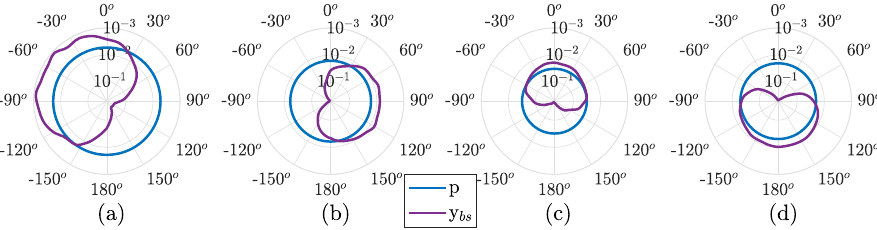
Figure 11. Polar BER for pressure ( p ) and beam steering ( y bs ) using Equation (6), for stations 3, 7, 12, and 14, from ( a – d ),